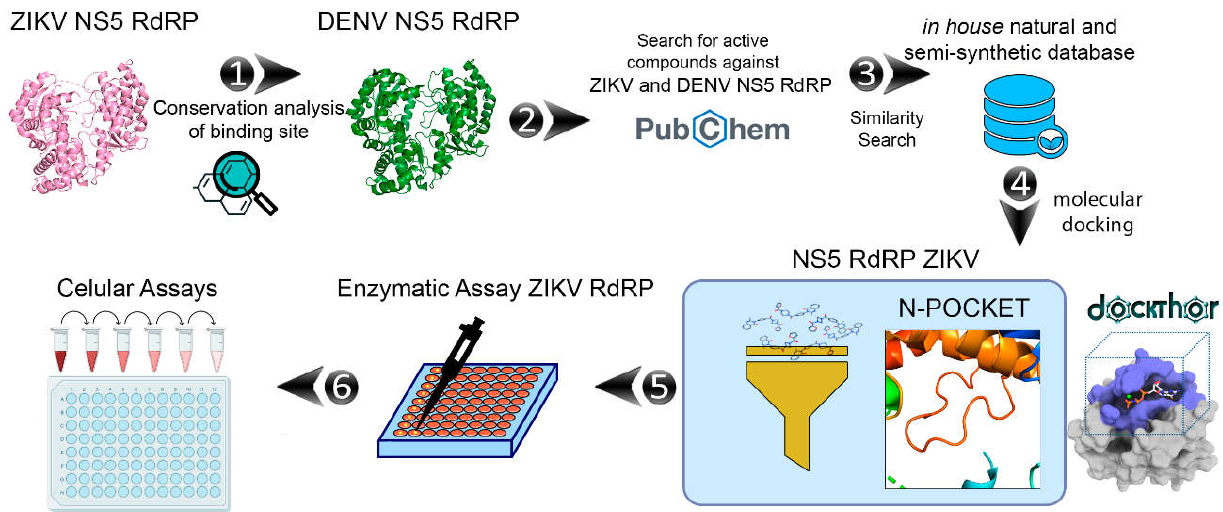
Figure 1. General workflow applied in this work to identify of ZIKV NS5 RdRp inhibitors: (1) conservation analysis of ZIKV NS5 RdRp; (2) collection of compounds with experimental data against DENV and ZIKV RdRp in the PubChem database; (3) similarity analysis between known RdRp inhibitors and in-house collection of untested compounds available on the Laboratory of Antibiotics and Chemotherapeutics (LAC); (4) molecular docking of prioritized compounds at the ZIKV NS5 RdRp N -pocket binding site; (5) enzymatic and (6) cellular